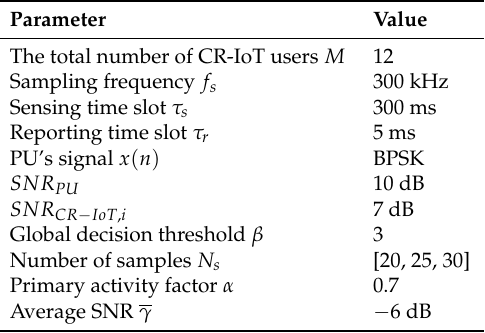
Table 1. Parameters used in